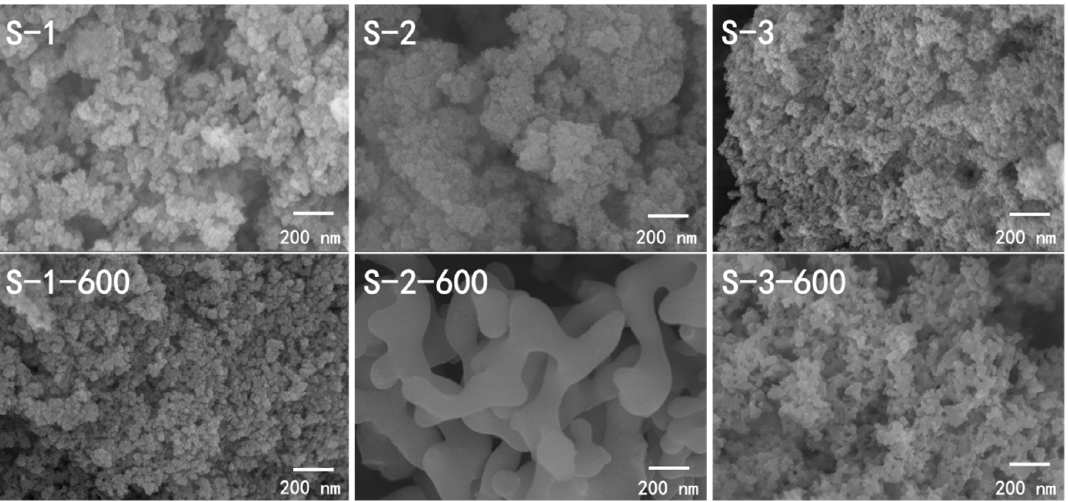
Figure 4. SEM images of silica aerogels prepared with different surfactants before and after heat treatment at 600 °C .